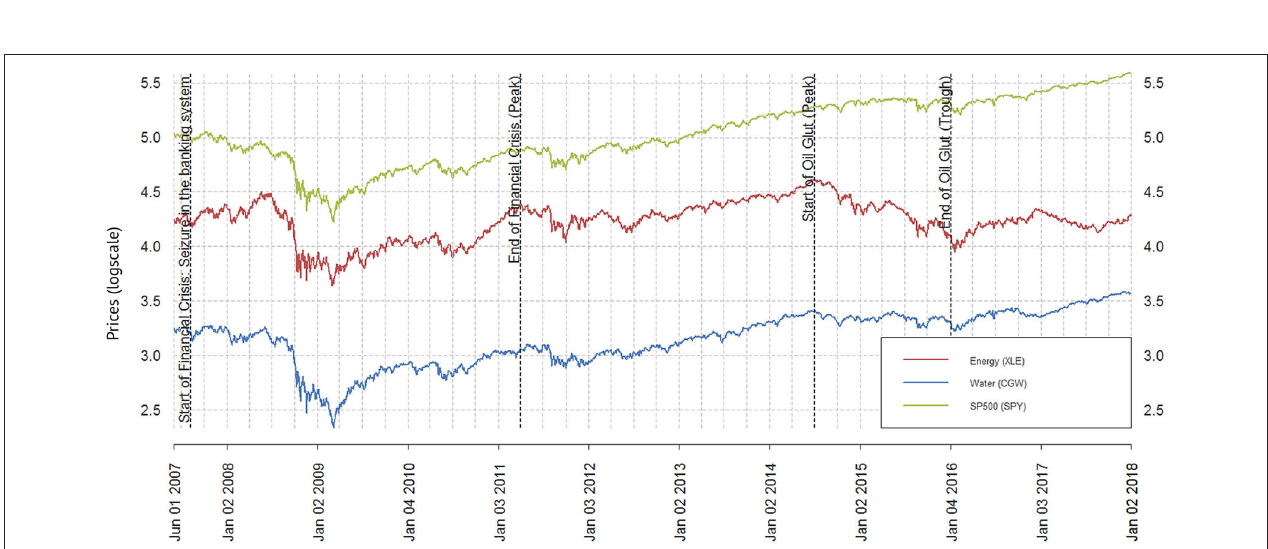
FIGURE 3 | Logscale closing price chart of the ETF’s: CGW, XLE, and SPY. Vertical lines are inserted to indicate the approximate (peak to peak) start and end dates of the 2008 financial crisis, two key events during the crisis, and the 2014–2016 global oil glut from peak to trough (Peterson and Carl, 2015).